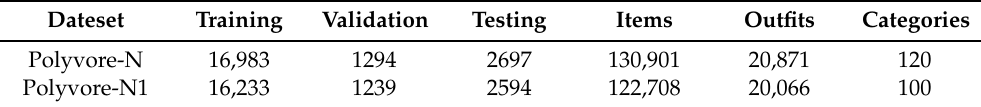
Table 1. Statistics of the